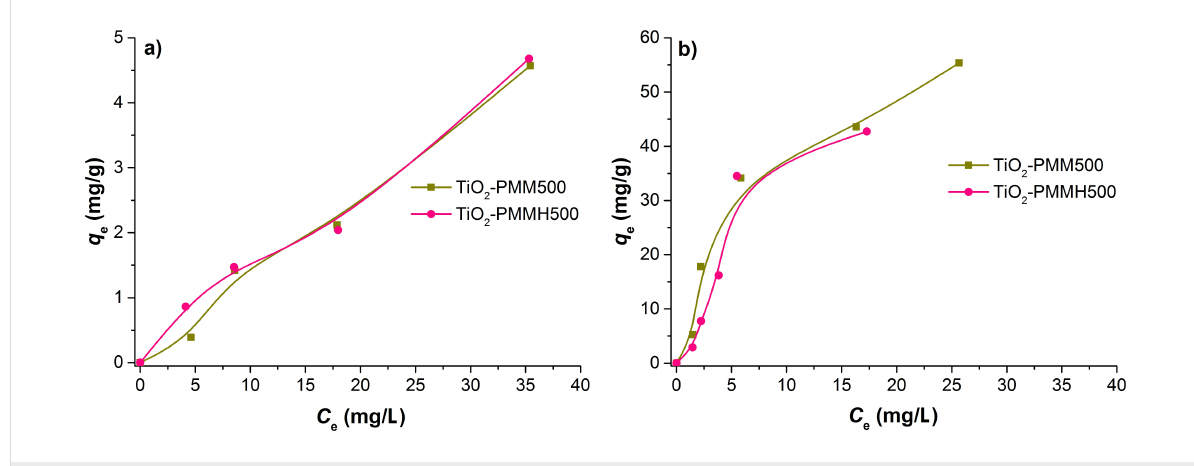
Figure 9: Adsorption isotherms of (a) MO and (b) RhB dyes at T = 20 °C.